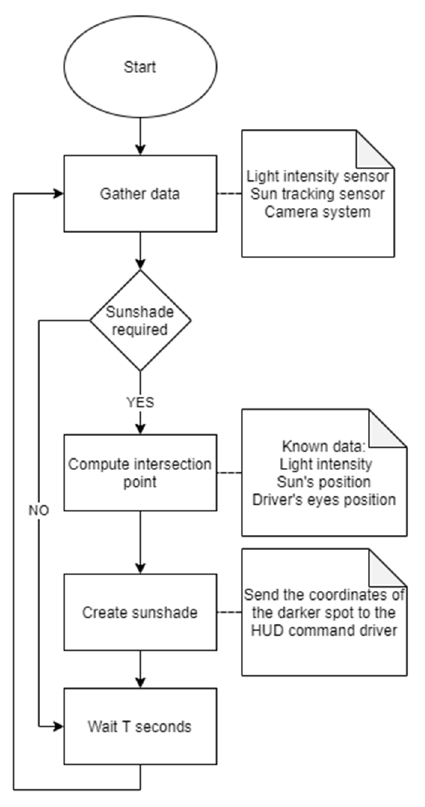
Figure 9. Shading system flow chart.